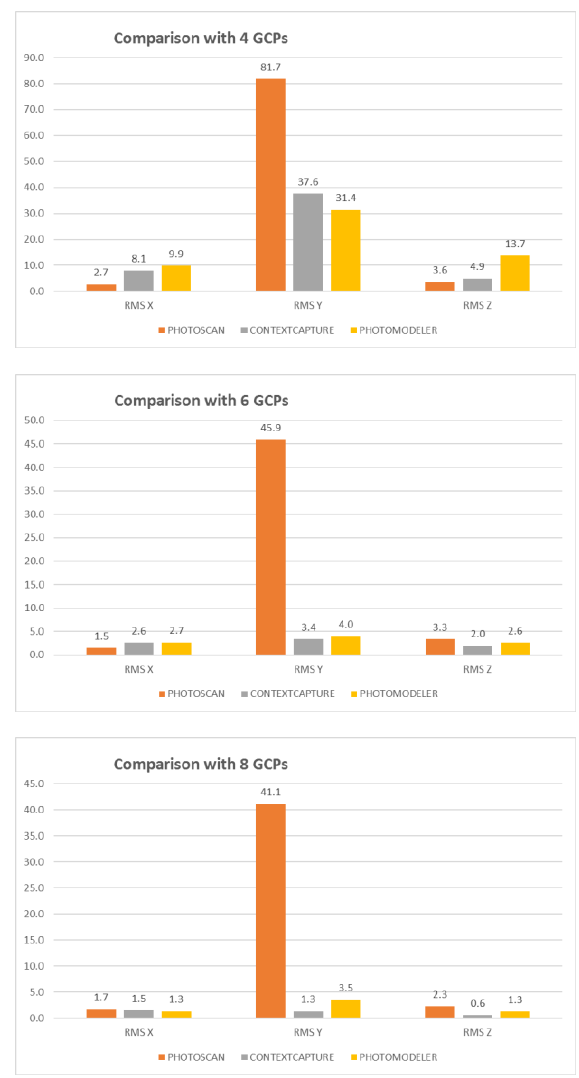
Figure 9. RMS of check points for the different software.